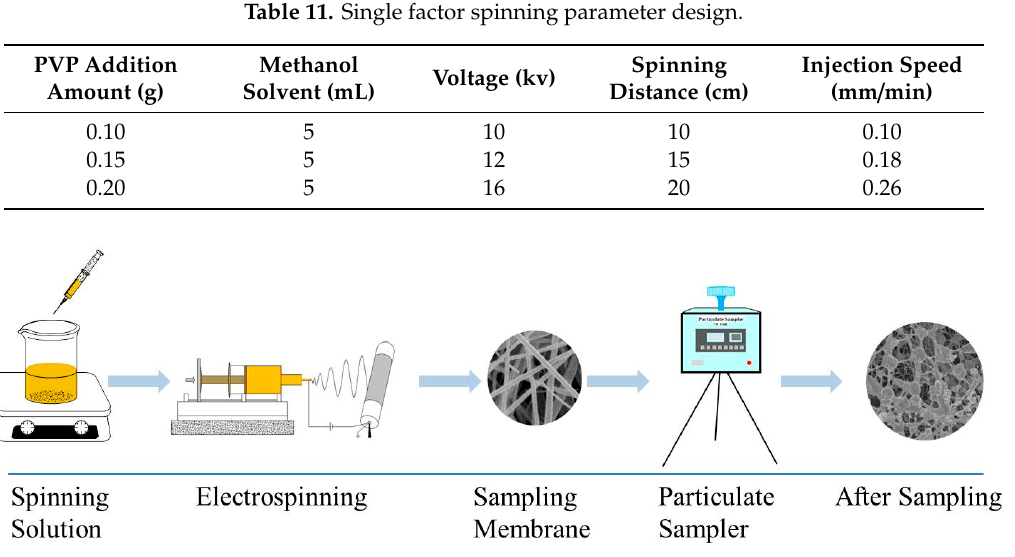
Figure 11. Flow diagram of the preparation of electrospinning active molecular membrane and application for capturing free radicals.